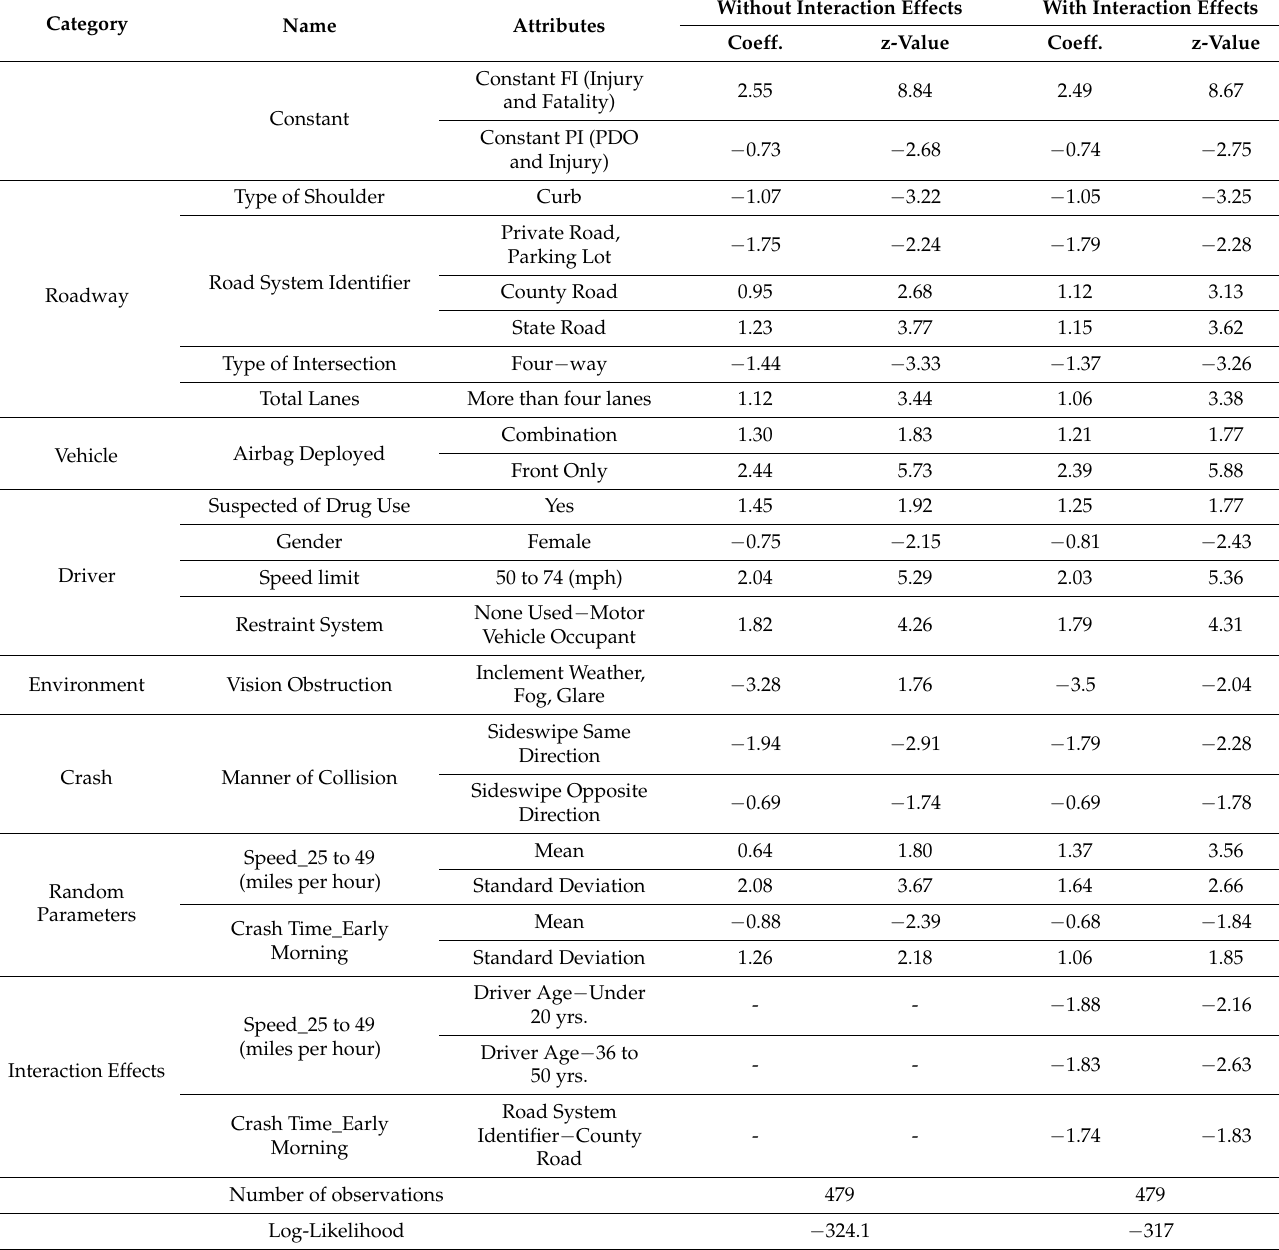
Table 3. Results of Random Parameter Ordered Logit